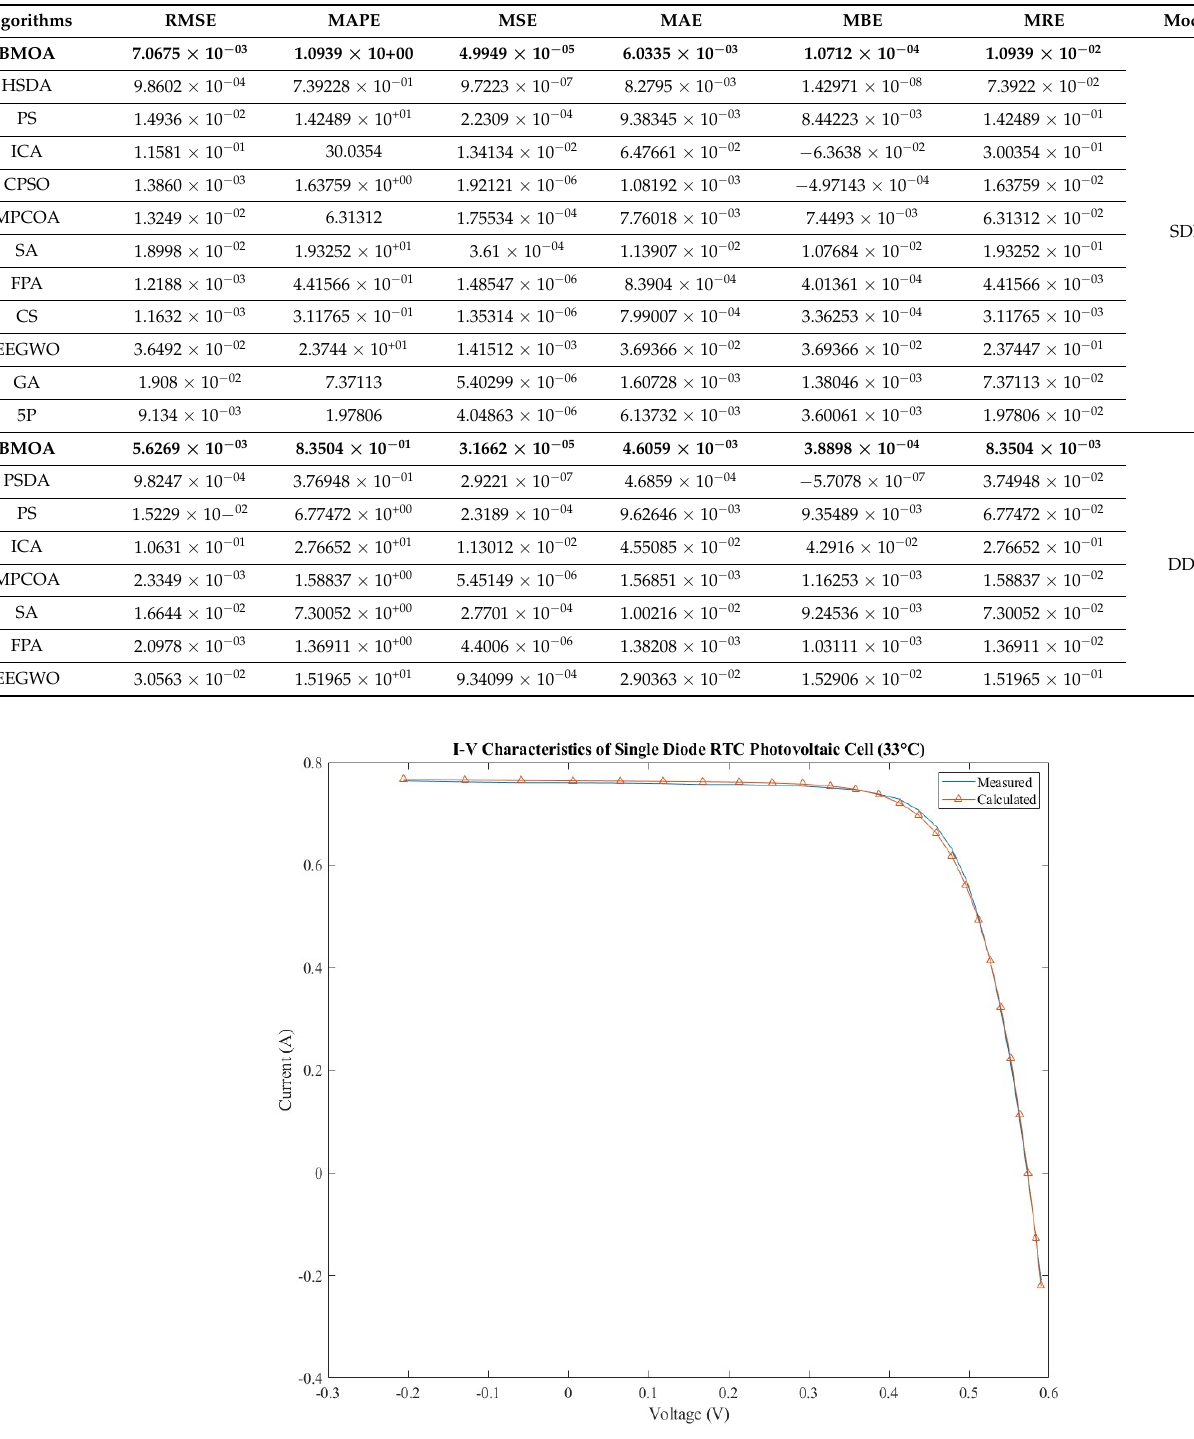
Table 10. RTC silicon photovoltaic cell (SDM and DDM) statistical tests.